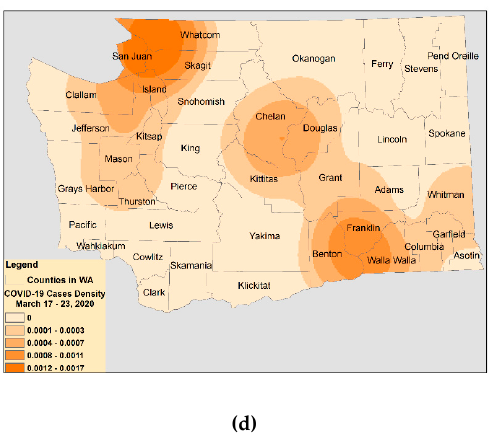
Figure 8. Kernel density estimation for COVID -19 spread during four time intervals: ( a ) 21 January to 4 March ( b ) 6 March to 9 March; ( c ) 10 March to15 March; ( d ) 17 March to 23 March.